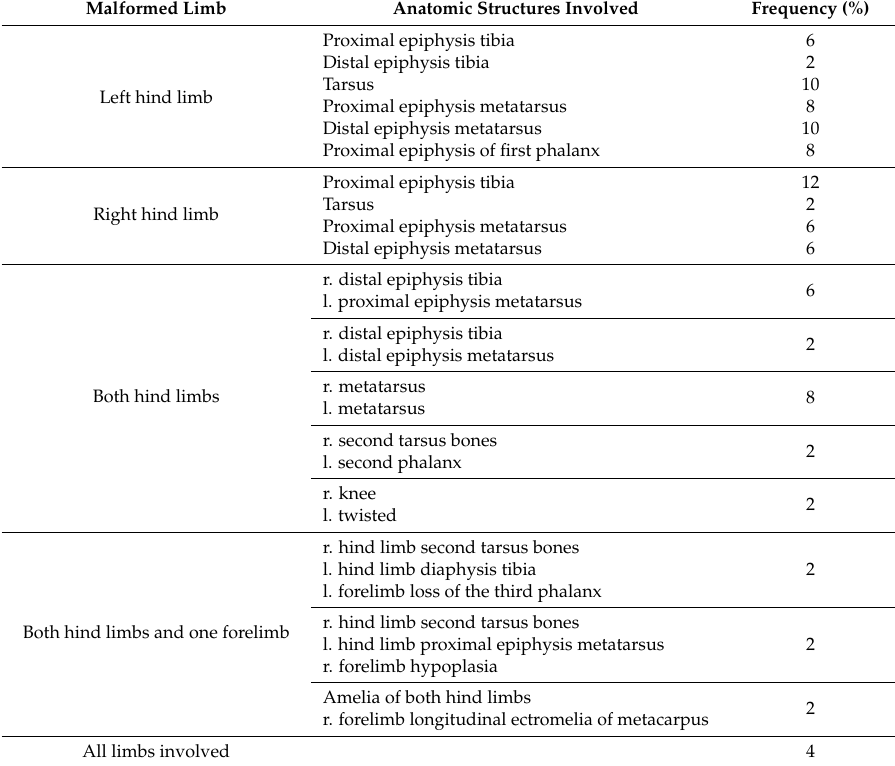
Table 2. Phenotypic trait of transverse hemimelia (TH) cases and their frequency in Mediterranean Italian River Buffalo (MIRB) of Italian breeding farms (data from the Department of Veterinary Medicine and Animal Productions, University Federico II,